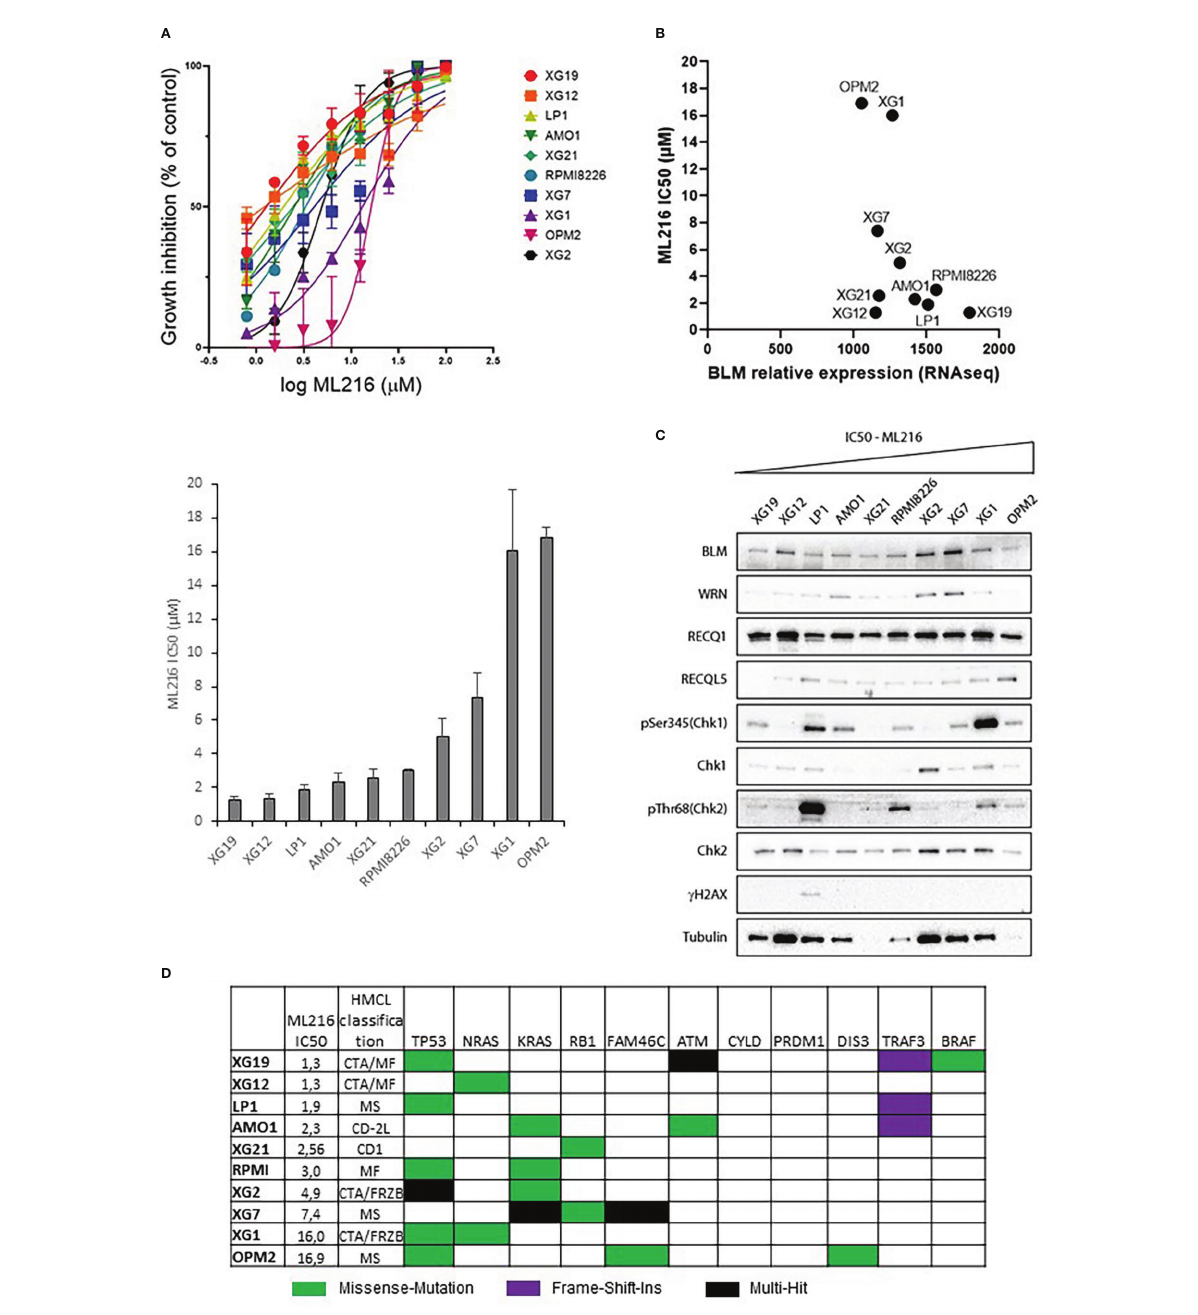
FIGURE 3 Effect of ML216 in HMCLs. (A) 10 HMCLs were treated with increasing doses of ML216 (0.78 – 100 m M). At day 4, cell viability was assessed using CellTiter-Glo Luminiscent Cell Viability Assay. IC50 for each cell line was calculated using GraphPrism software. Upper panel shows the non- linear regression curve of growth inhibition for all HMCLs. Low panel shows the IC50 value for each HMCL. Data are based on at least 3 independent experiments. (B) BLM expression and sensitivity to ML216 (IC50) do not correlate after applying a Spearman ’ s test. (C) Western blot analysis of the protein level of the RECQ helicases and basal DDR markers in 10 HMCLs. Cell lines are ranked from left to right in order of increasing IC50 for ML216. Note that in most cell lines protein levels do not correlate with BLM expression levels determined by RNAseq in Figure 3B. (D) Mutational status of MM frequently mutated genes in the 10 HMCLs used for the other experiments in this fi gure. “ HMCL classi fi cation ” refers to the MM molecular group classi fi cation. PR (cell cycle and proliferation), LB (low bone disease), MSET (aberrant expression of FGFR3 and MMSET genes), HY (hyperdiploid signature), CDNN1 (overexpression of Cyclin D1), CDNN2 (overexpression of Cyclin D2), and MAF (overexpression of MAF and MAFB genes) (72). Data extracted from